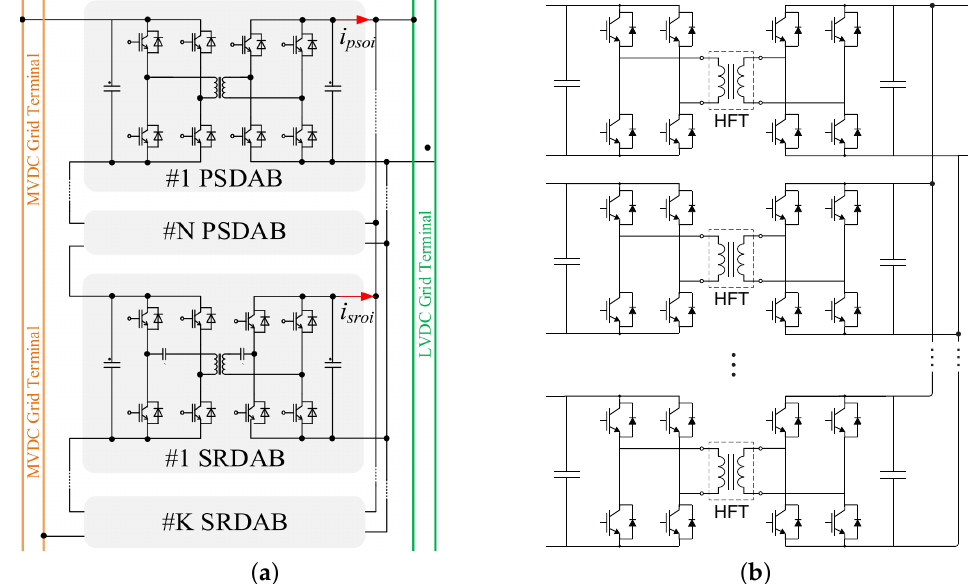
Figure 20. Some of the most investigated converter arrangements in an SST DC/DC stage. ( a ) ISOP resonant and non-resonant DAB converters [98], ( b ) Separated-input paralleled-output DAB converters [100].